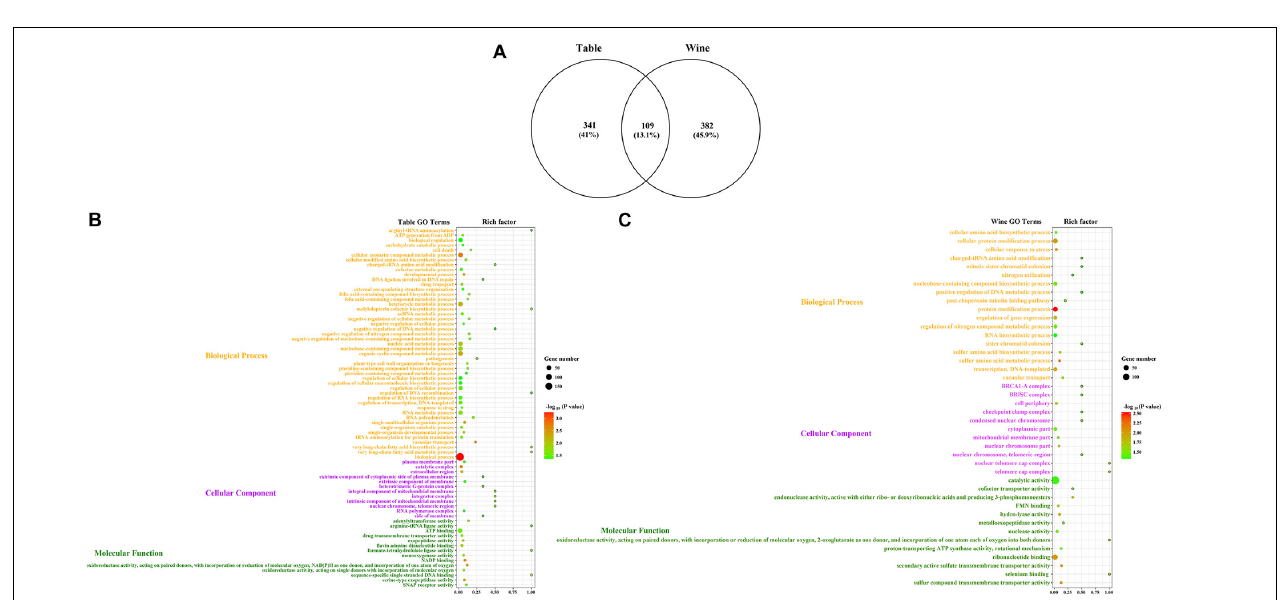
FIGURE 5 | GO enrichment of the candidate selective sweep genes from the CLR analysis. (A) Venn plot of the GO terms shared by table and wine grapes. Bubble plots of enriched GO terms for (B) the table grapes ( n = 30) and (C) wine grapes ( n = 30). The size of the bubble represents the number of genes in the corresponding GO category. The color of the bubble shows the corresponding P -value. Rich factor shows the percentage of enriched genes out of the total number in the GO